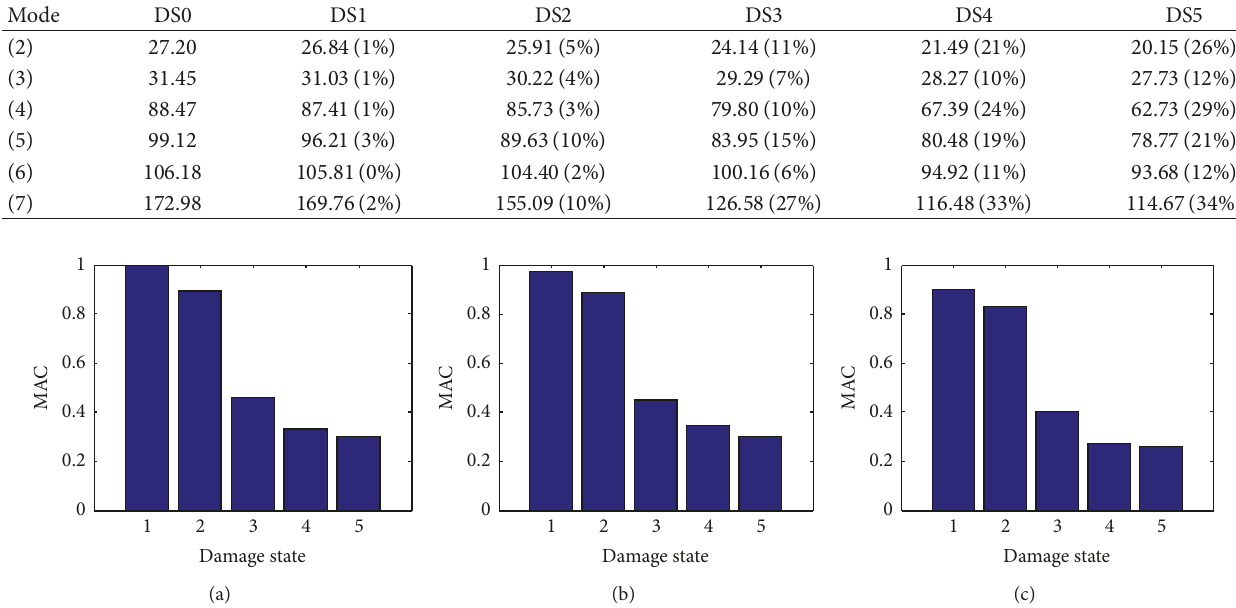
Table 2: Modal frequencies (Hz) at different DS and their variation relative to DS0.